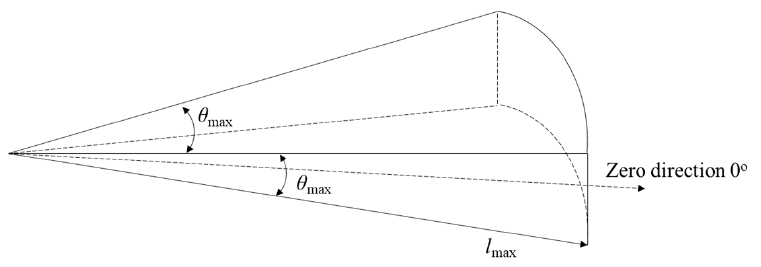
Figure 1. The pursuit angle of the